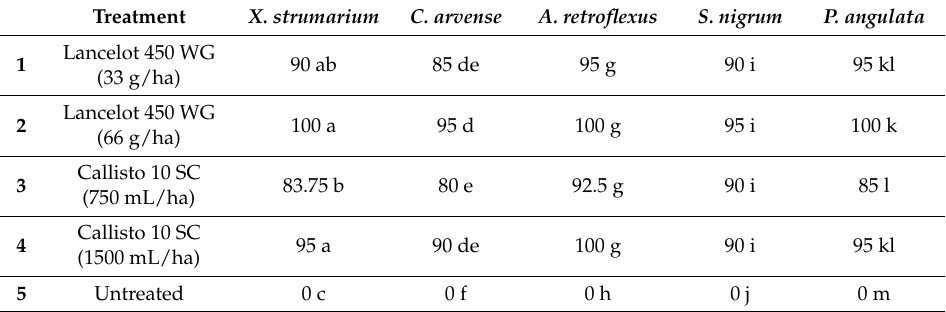
Table 4. Efficacy assessment (%) of the several treatments on broadleaf weeds at 14 DAT. Treatment